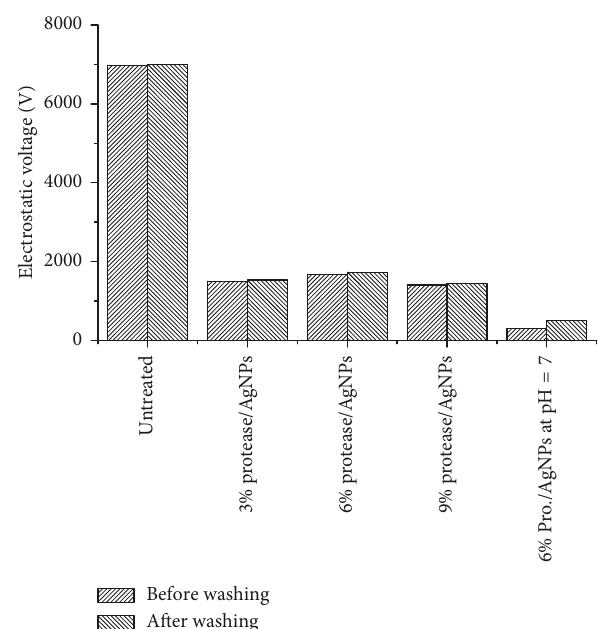
Figure 7: The interaction voltage of wool after